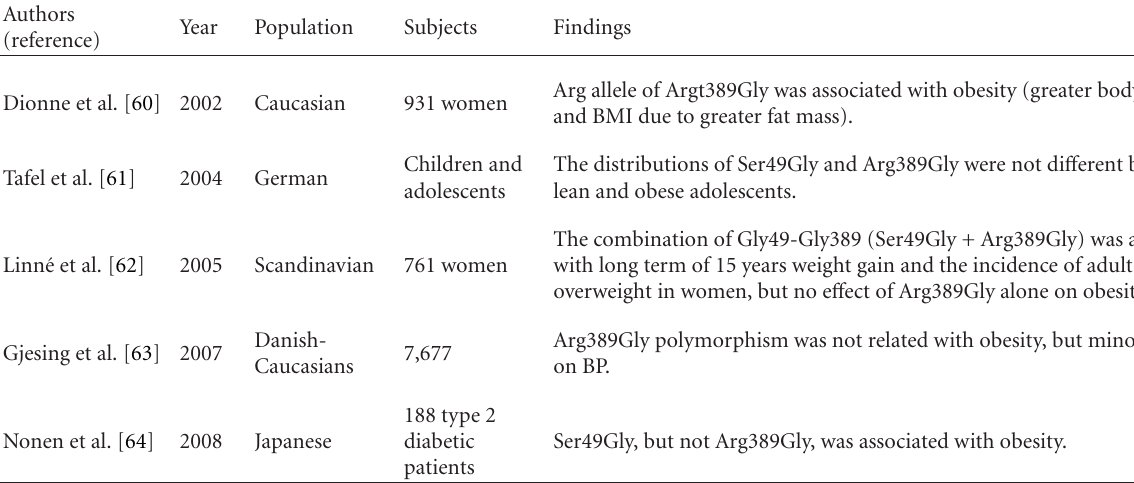
Table 1: Summary of studies showing associations between on β 1-adrenoceptor polymorphisms and